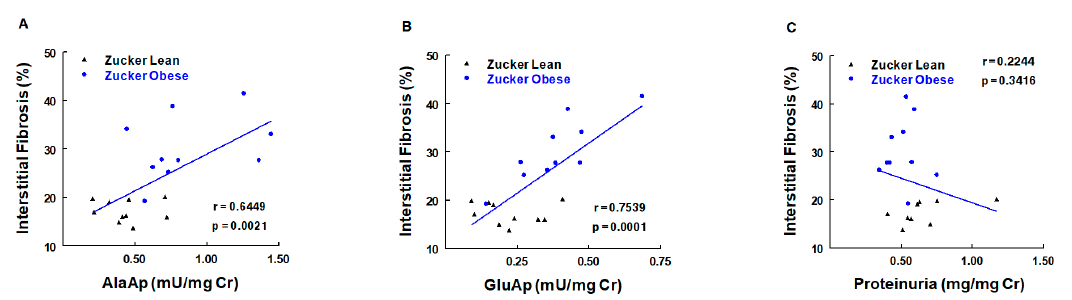
Figure 6. Correlations of urinary activities of APN (AlaAp) ( A ), APA (GluAp) ( B ), and proteinuria ( C ) with percentage of renal interstitial fibrosis in urine samples of Zucker lean and obese rats ( n = 10 each group). Cr = creatinine (adapted from reference [126]).